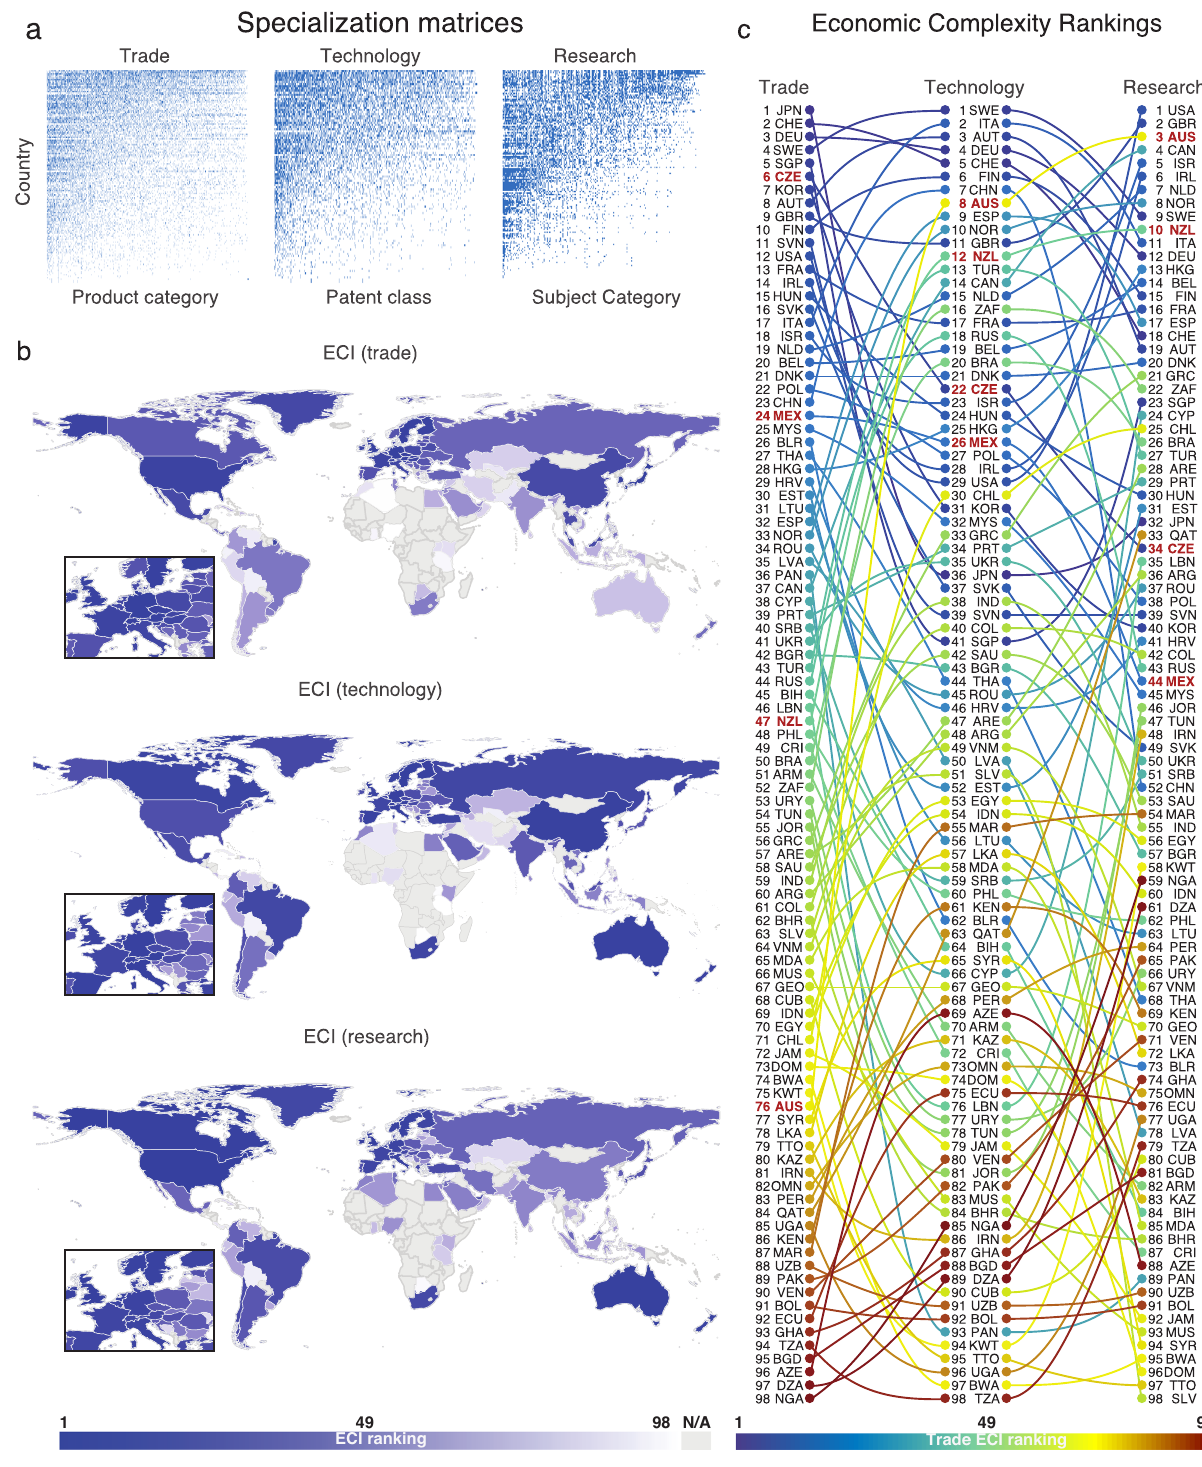
Fig. 1 Multidimensional economic complexity. a Specialization matrices of countries considering exports by product, patents by technology, and publications by subject category. b Maps showing the rankings of ECI (trade), ECI (technology), and ECI (research). c Comparison between the ECI rankings of countries based on ECI (trade), ECI (technology), and ECI (research). a – c All data are for the year 2014.